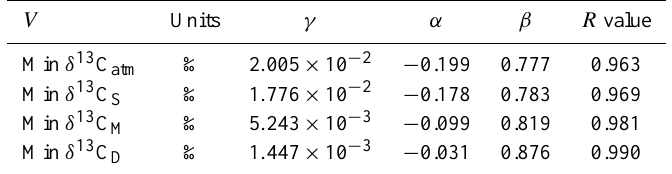
Table 8. Power law scalings for Paleocene and Eocene configuration, δ 13 C variables, and (cid:49)V = γD α E β . D in yr and E in PgC.